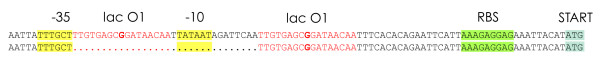
Sequence Analysis. Sequence of the promoter/operator region, identical in pMPAG6 (lacIq+) and pMPAG77 (lacIq-) (top line), and alignment with the deletions (bottom line) isolated from lacIq-E. coli strains harboring the respective lacIq- expression vector: identical sequences were found in at least 6 independent clones of each construct protein. The -35 and -10 regions are indicated by yellow boxes; the two lac O1 operator sites are marked by red letters (length defined as the LacI contact residues seen by NMR [36], with each symmetry center in bold). The ribosomal binding site (RBS) is highlighted in green and the start codon in light blue, respectively.